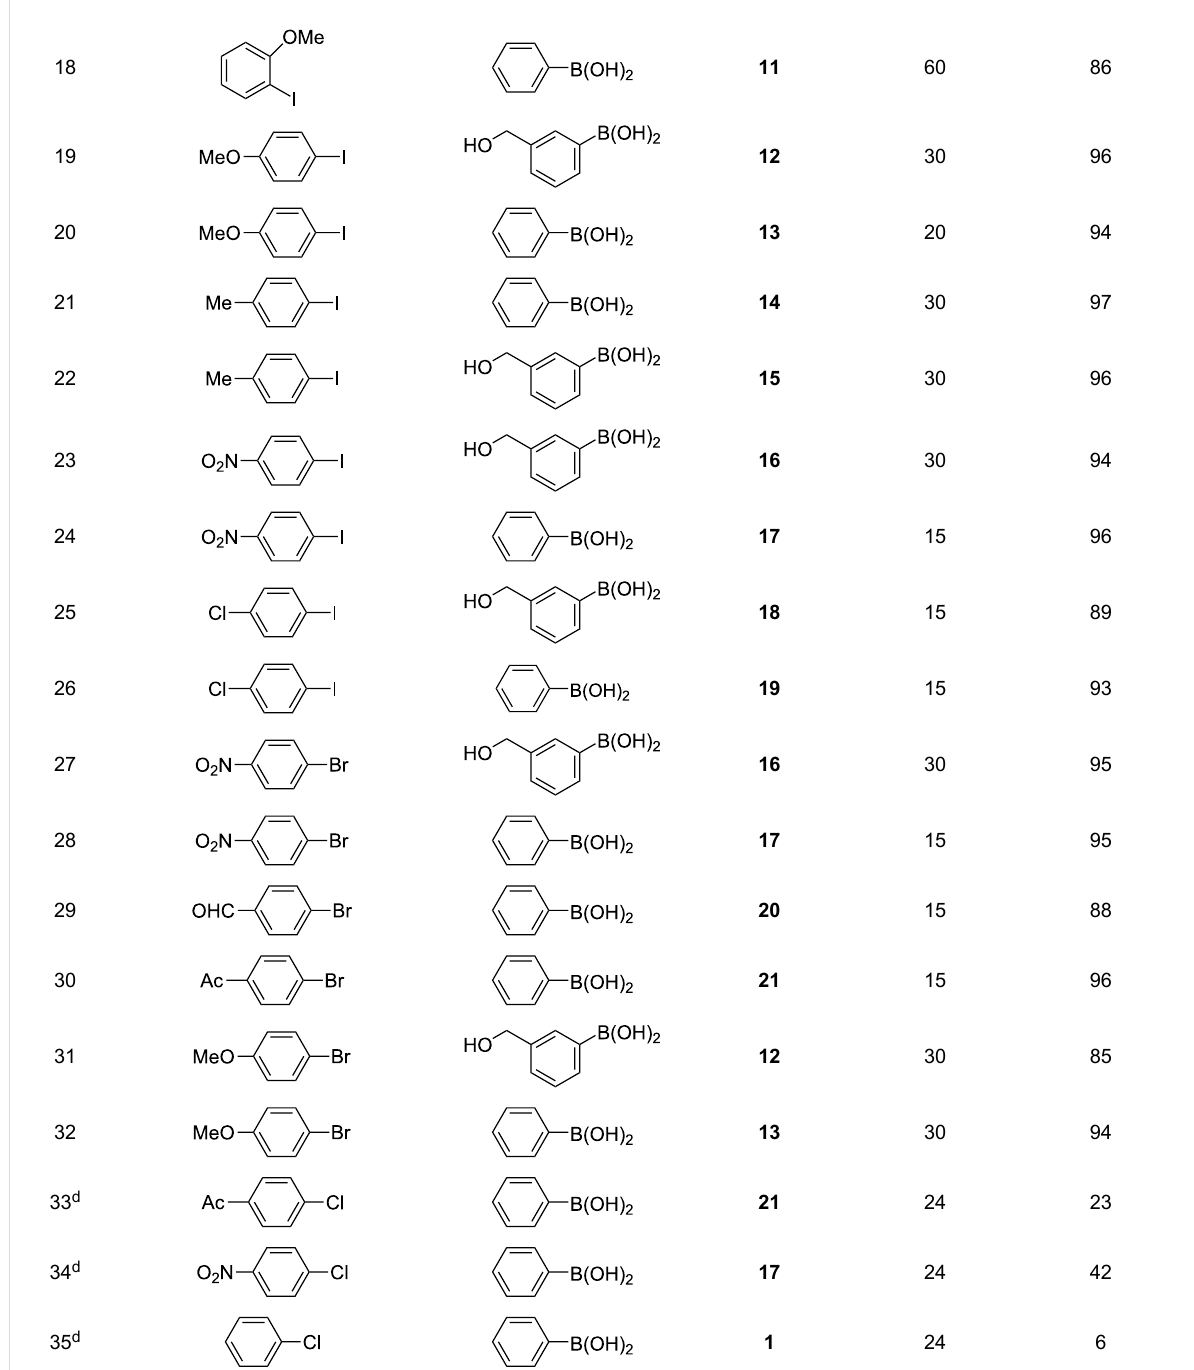
Table 4: Suzuki cross coupling reaction of aryl halides with arylboronic acid a .